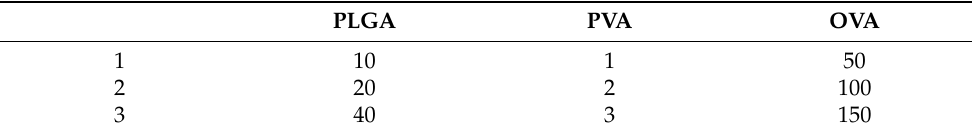
Table 1. Factors and corresponding levels for experimental design and optimization.